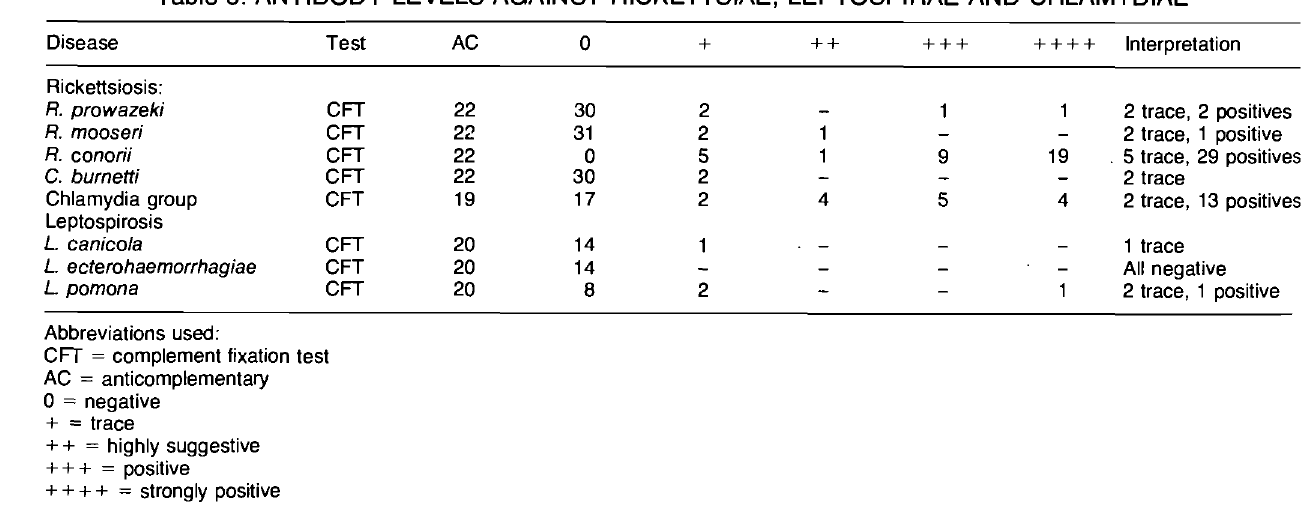
Table 5: ANTIBODY LEVELS AGAINST RICKETISIAE, LEPTOSPIRAE AND CHLAMYDIAE